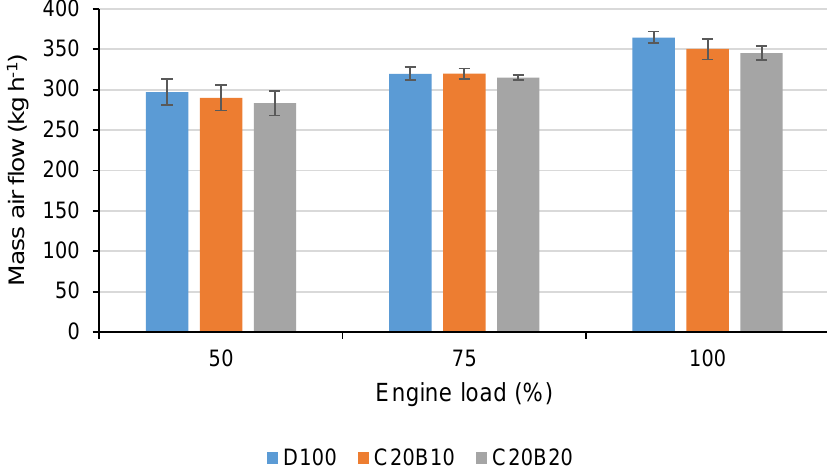
Figure 11. Mass air flow in relation to engine load for all tested fuels (error bars represent the standard deviation).